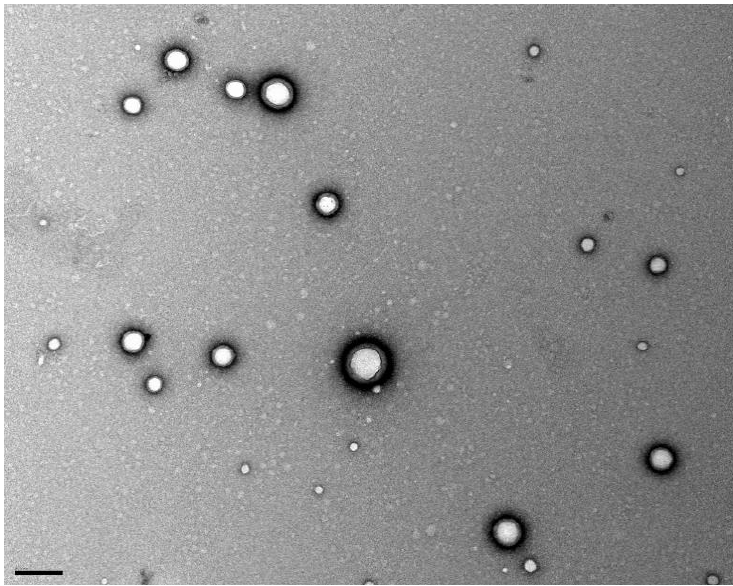
Figure 8. TEM photograph showing the morphology of the developed PLGA NPs. Scale bar is 200 nm.